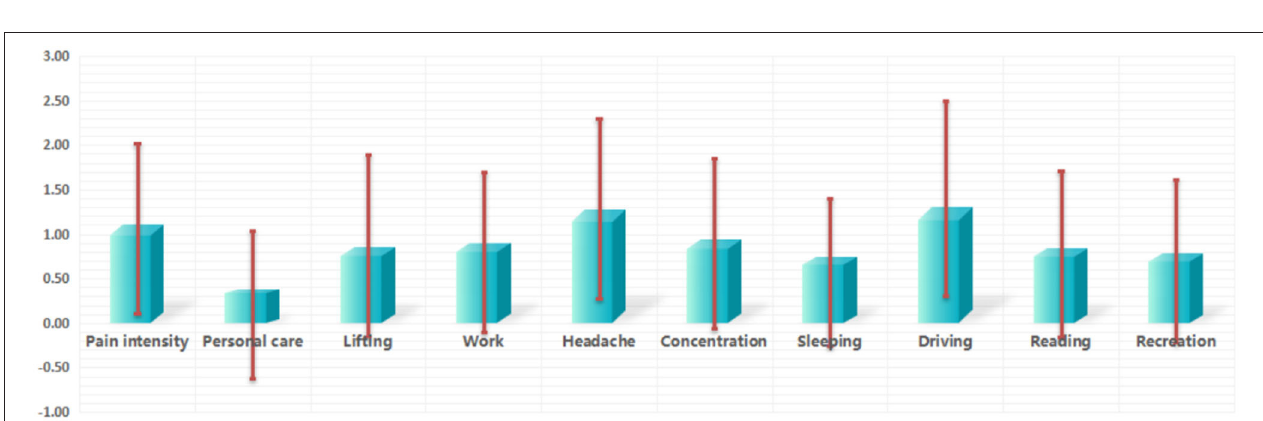
FIGURE 3 | Item-total score of the